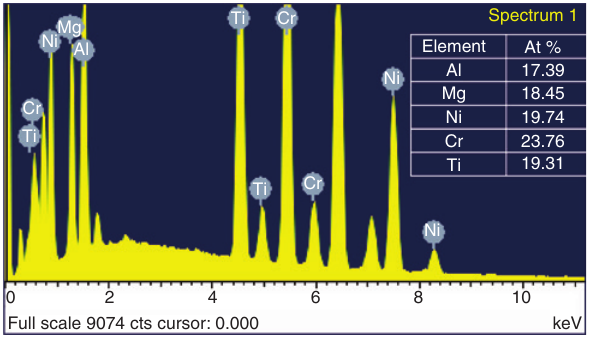
0 2 0.0004 Full scale 9074 cts cursor: Figure 5: EDS spectrum and quantitative analysis of AlMgNiCrTi HEA after SPS at 800 °